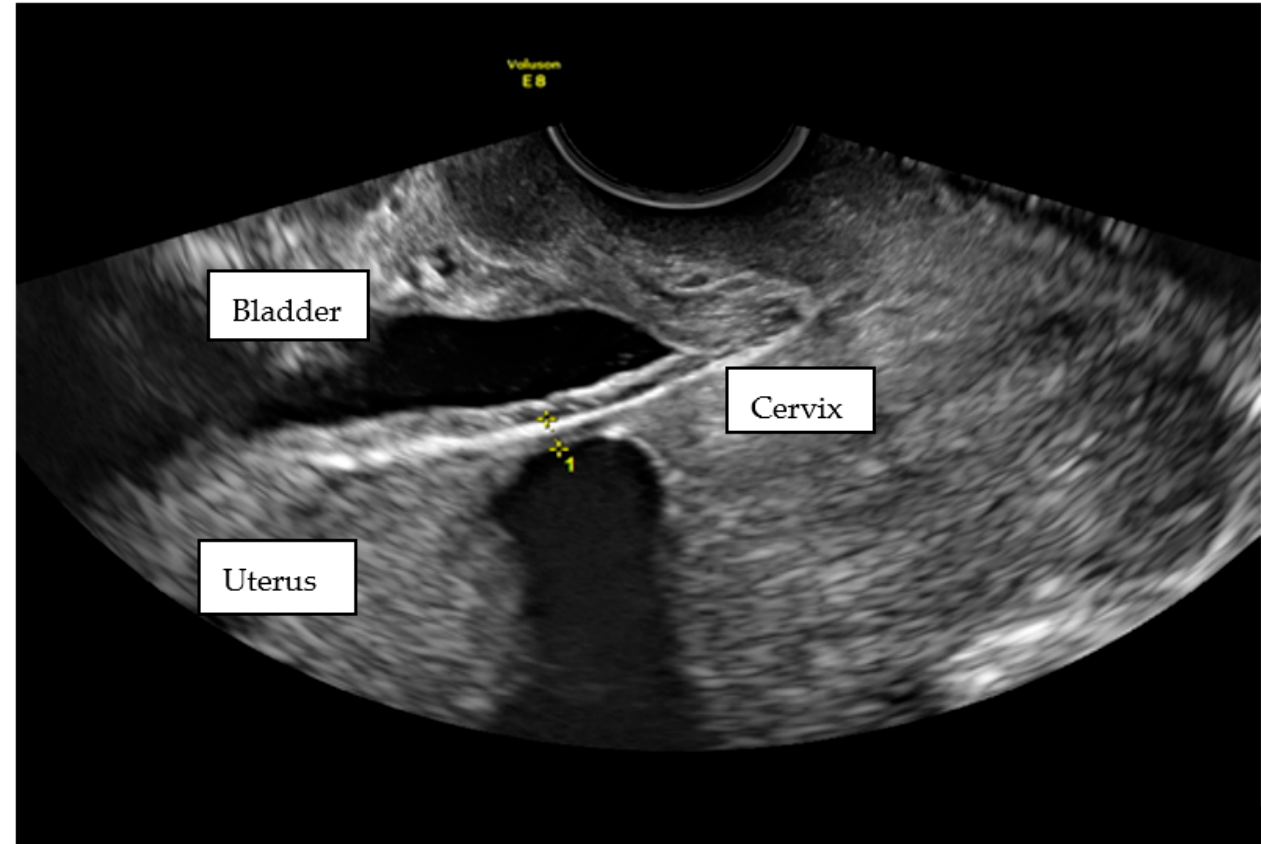
Figure 8. Transvaginal scan of pregnant lower segment of uterus at 21 wks. The measurement of the scar thickness was 3.4 mm.